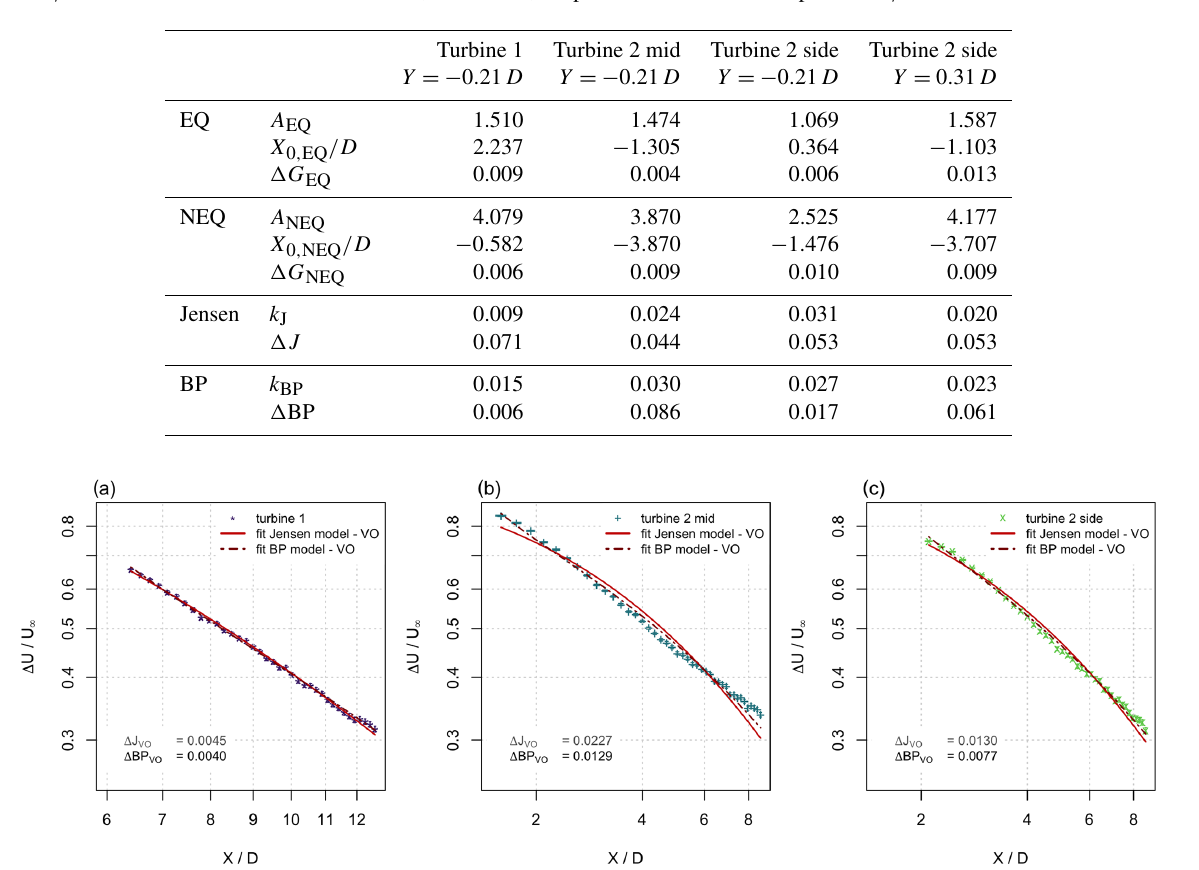
Table 3. Fit parameters and RMS errors for the different models predicting the evolution of (cid:49)U/U ∞ for the three scenarios at the radial position Y/D = − 0 . 21. Note that for turbine 2 side, in addition, the parameters for the radial position Y/D = 0 . 31 are included.